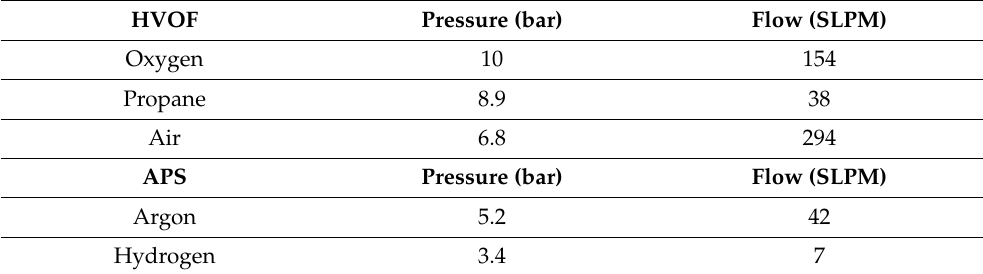
Table 1. Pressure and flow rate of the gases.